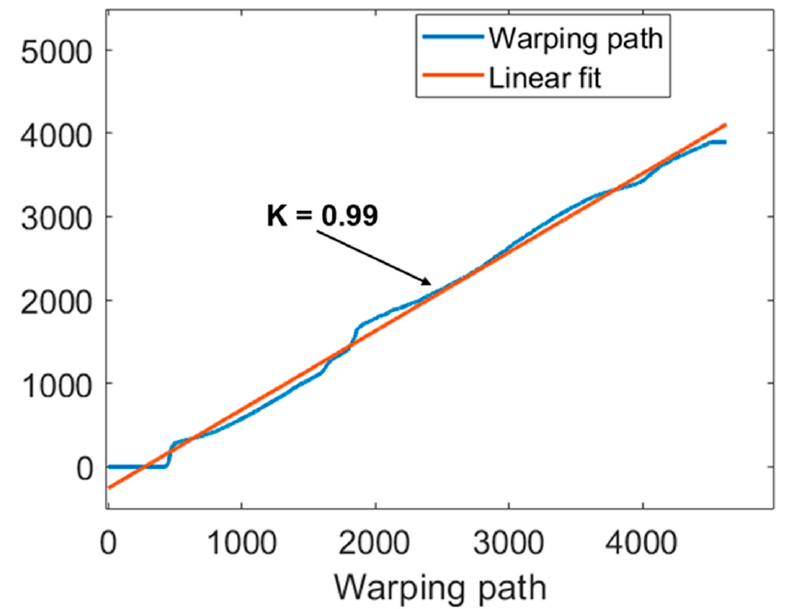
Figure 8. The warping path and the slope of linear fitting.